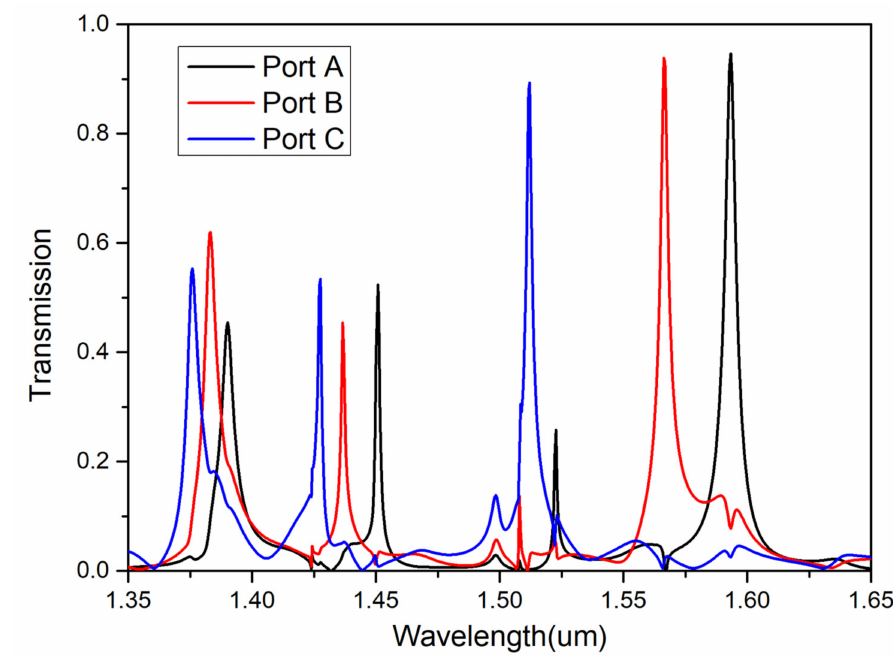
Figure 9. Transmission spectrum of the reduced photonic crystal